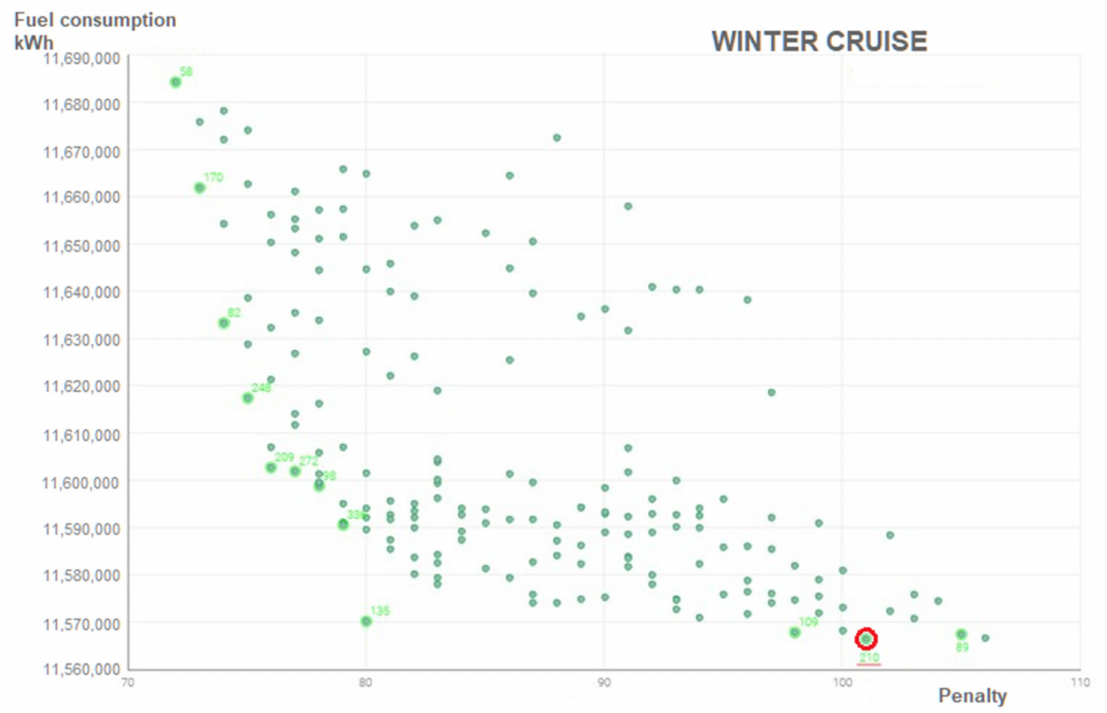
Figure 12. Pareto front of the optimal solutions in the winter case. The red circle indicates the most interesting solutions from the point of view of reducing